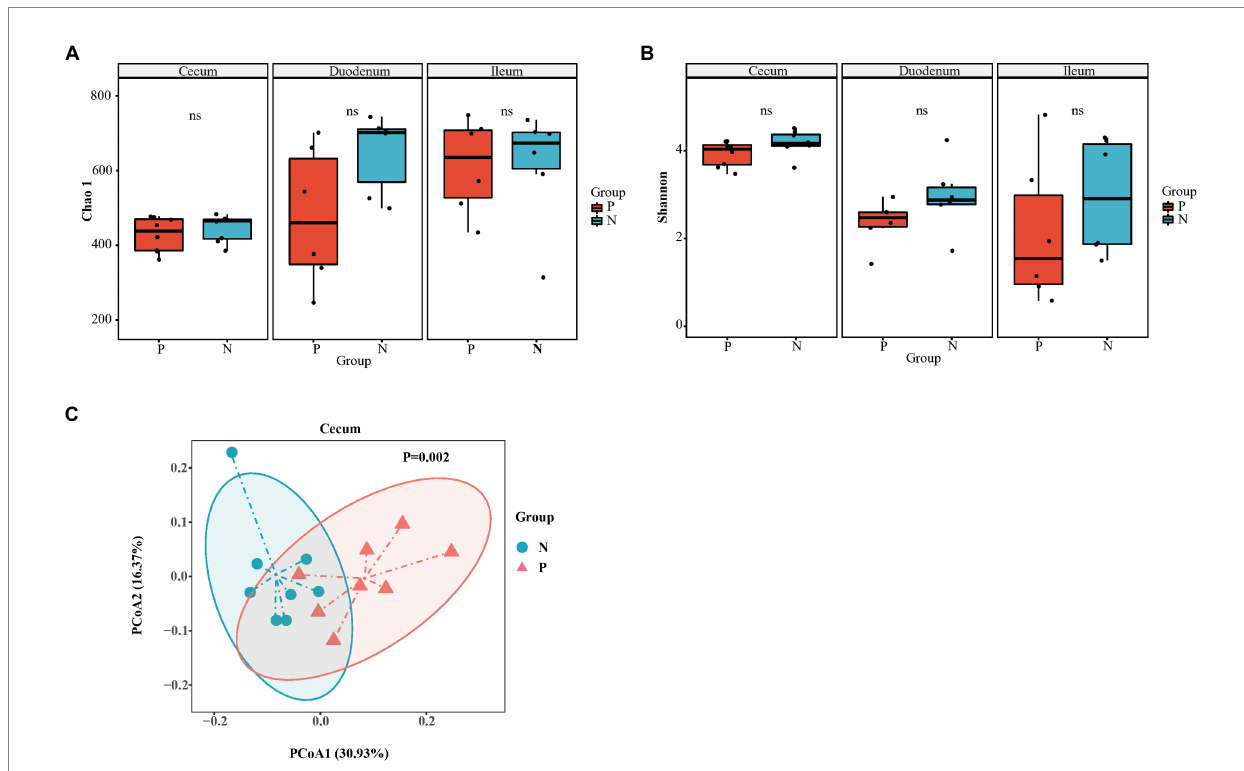
FIGURE 3 The diversity of gut microbiota of laying hen with different FP phenotype. (A) Chao 1 index of cecum ( n = 8), duodenum ( n = 6) and ileum ( n = 6); (B) Shannon index of cecum, duodenum and ileum; (C) The principal co-ordinates (PCoA) analysis of cecum based on the unweighted unifrac distance. P = feather pecker, N =